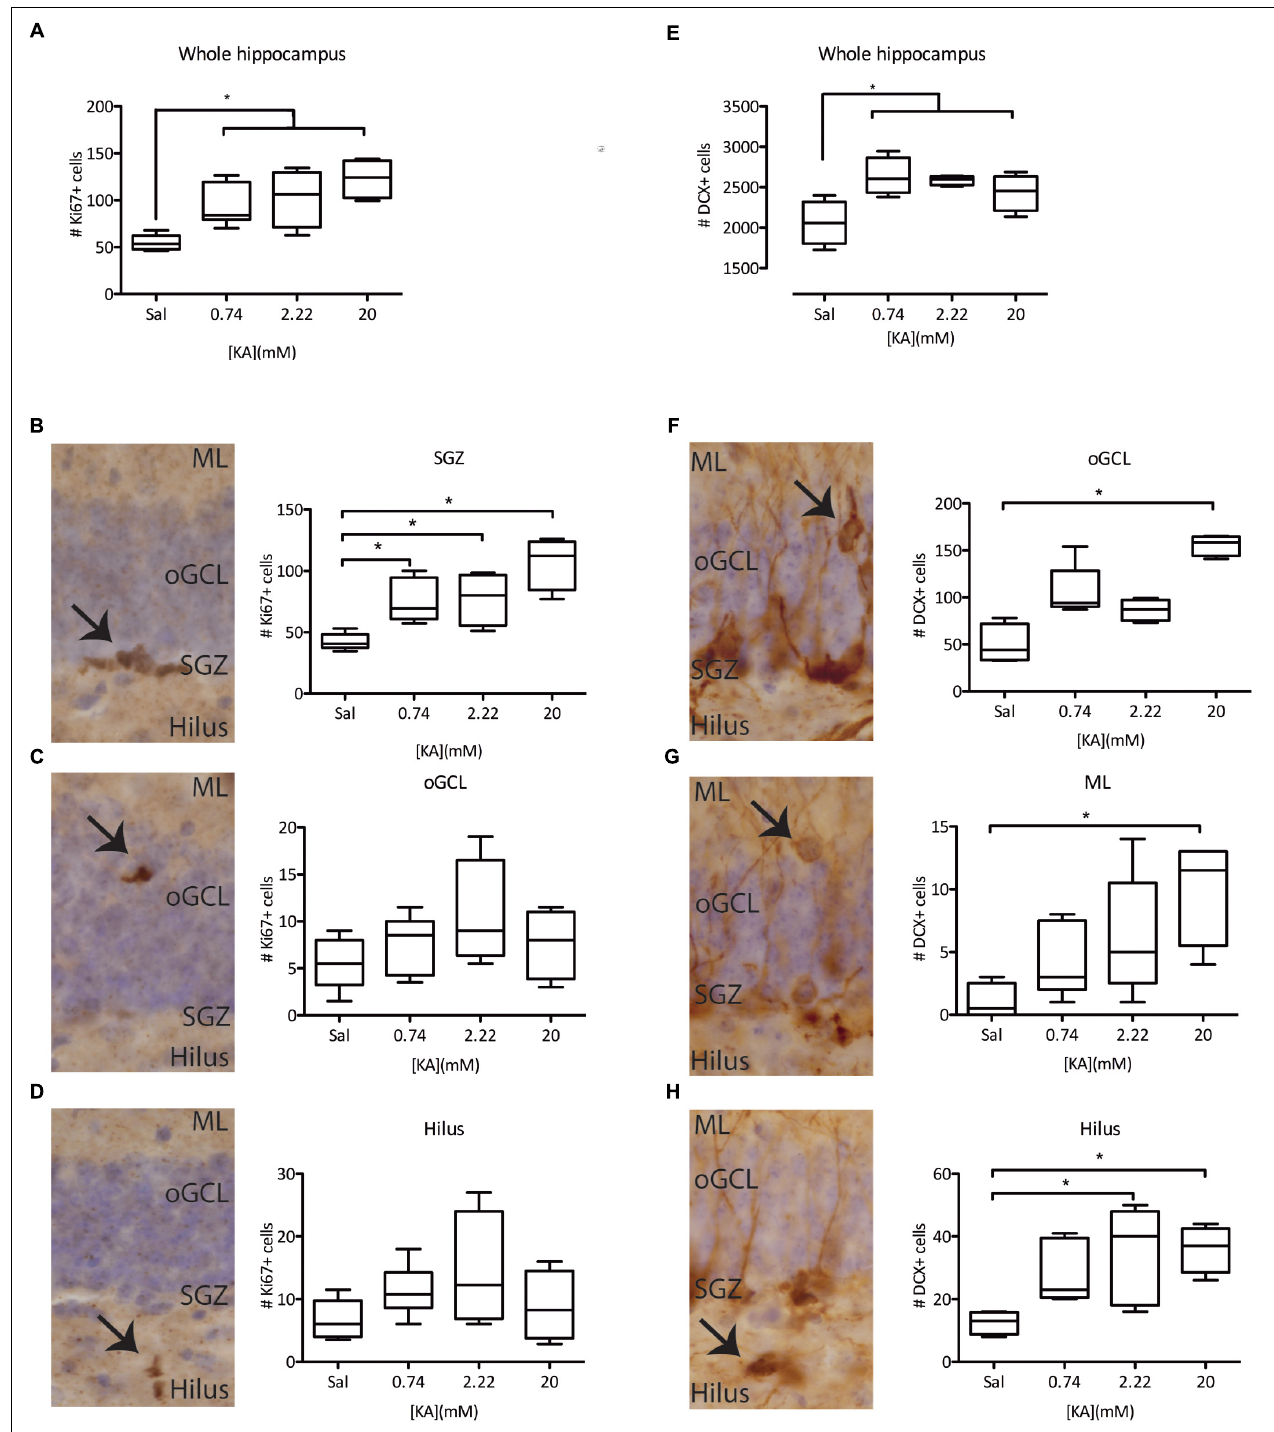
FIGURE 2 | Characterization of KA dose-dependency on proliferation and immature (DCX+) neurons. (A) Immunohistochemistry against Ki67 reveals an induction in the total proliferation in the whole hippocampus of the dentate gyrus, independent of KA dose. This effect is mainly driven by increased proliferation in the SGZ (B) of the DG, and not by ectopic proliferation in the oGCL (C) or the Hilus (D) . (E) Immunohistochemistry against DCX reveals an induction of DCX+ immature neurons in the whole hippocampus, irrespective of the KA dose. However, ectopic DCX+ immature neurons are only present in the oGCL (F) , the ML (G) , or the hilus (H) after higher KA doses. ∗ p < 0.05 arrows indicate immunopositive cells at each studied location.